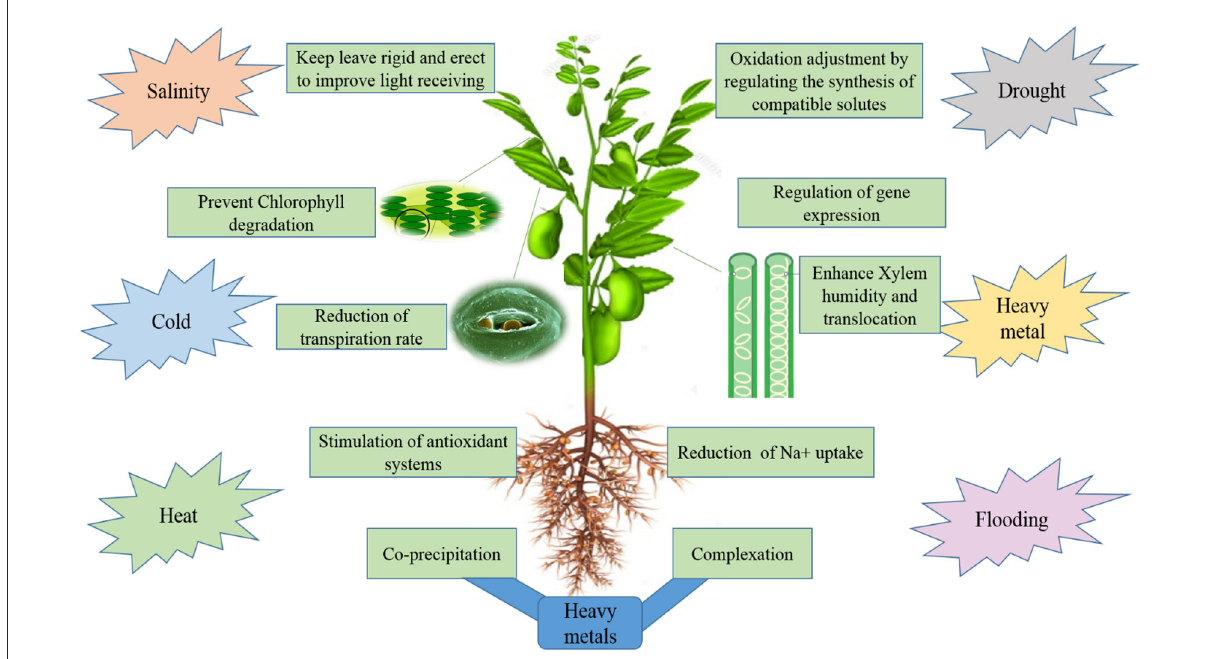
FIGURE3 Exploring the effect of abiotic stresses on the growth of legume crops.